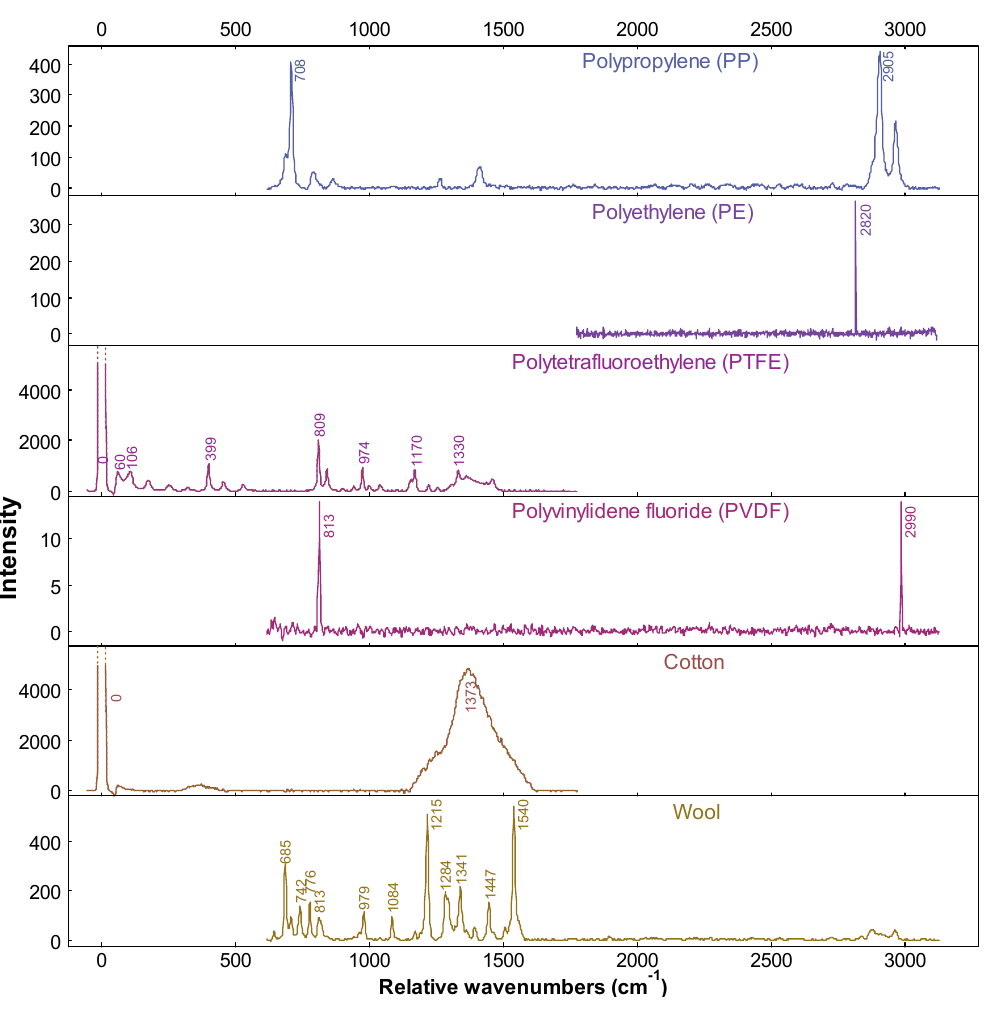
Figure 3. Raman spectra (intensity vs . relative wavenumbers, cm −1 ) used to classify polymer materials identified from the microplastic subsamples which were identified visually. The main peaks for each spectrum are labelled with their positions in relative wavenumbers.